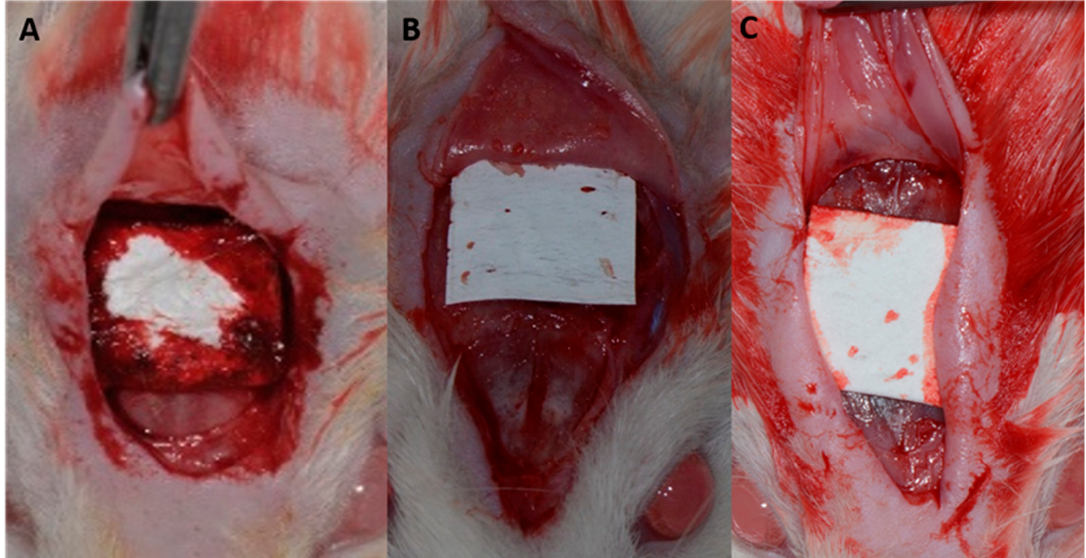
Figure 2. ( A ) Bio-Gide ® porcine collagen membrane fitted over the bone defect; ( B ) Jason ® porcine dermis collagen membrane adapted over the bone defect; and ( C ) Collprotect ® porcine pericardium collagen membrane adapted over the bone defect.